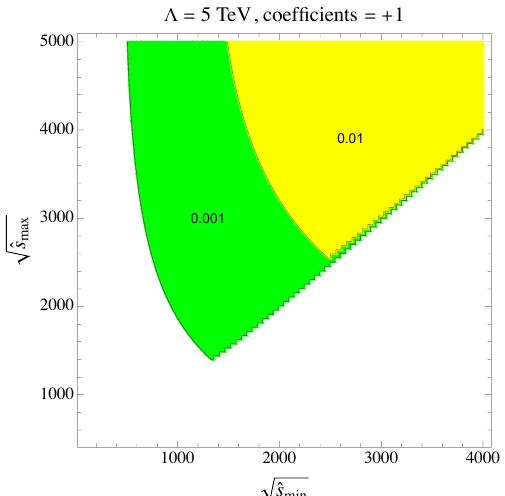
Figure 8 . Ratio of the O (1 / Λ 6 ) contributions relative to the SMEFT dilepton cross section to √ √ ˆ s and the maximum ˆ s , O (1 / Λ 4 ) as a function of the minimum center of mass energy min max ( σ ( pp → ‘ + ‘ − ) ) /σ ( pp → ‘ + ‘ − ) . All Wilson coefficients are − σ ( pp → ‘ + ‘ − ) O (1 / Λ 6 ) O (1 / Λ 4 ) O (1 / Λ 4 ) taken to be positive and equal to one, and the new physics scale Λ = 5